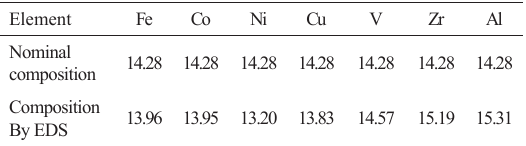
Table 1: Composition of the FeAlCuCrCoMn high-entropy alloy target (at.%) Element